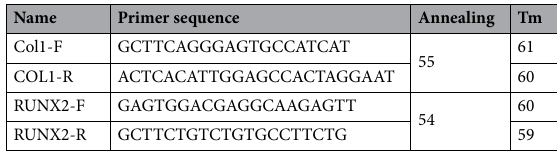
Table 1. Primers design details used in this study.